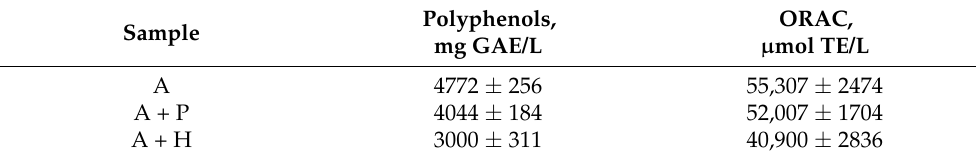
Table 1. Polyphenol content and ORAC antioxidant activity of aronia-based functional